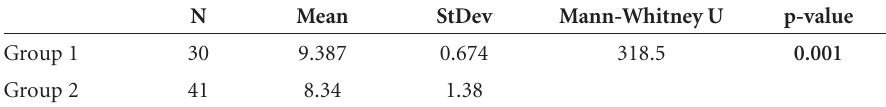
Table 2. Mann-Whitney test for alpha spectral peak EEG (group 1 vs group 2).